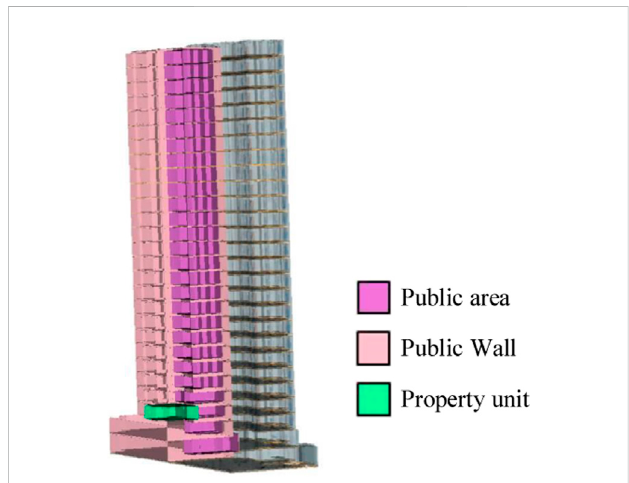
FIGURE 5 The legal entity model of the real estate registration object and the spatial distribution diagram of the property right sharing area.